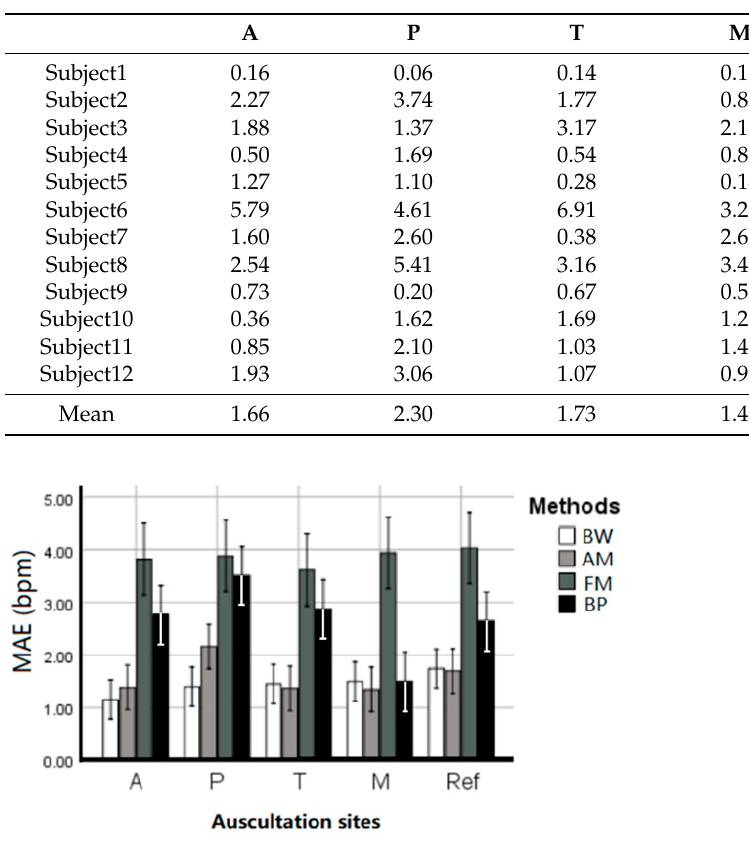
Figure 5. The performance (MAE ± SE bpm) of the EDR algorithms on different auscultation sites and Lead 1 ECG signals.